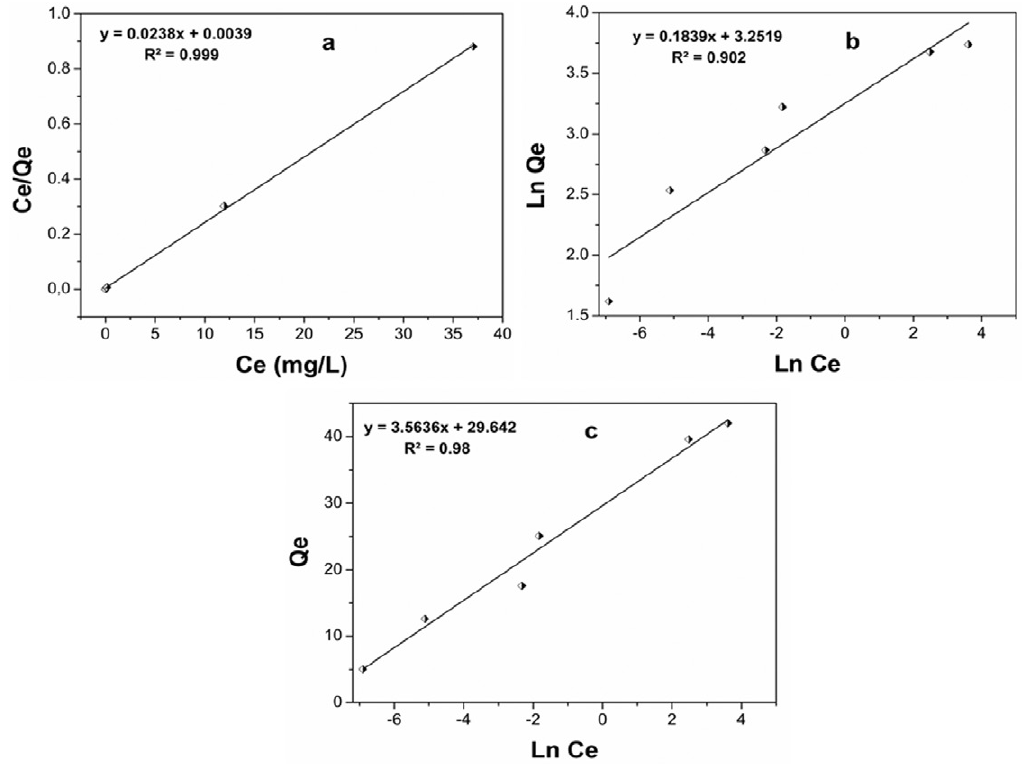
Fig. 9. Langmuir isotherm (a), Freundlich isotherm (b) and Temkin isotherm (c) for Mn (II) adsorption on Ac-OFIP